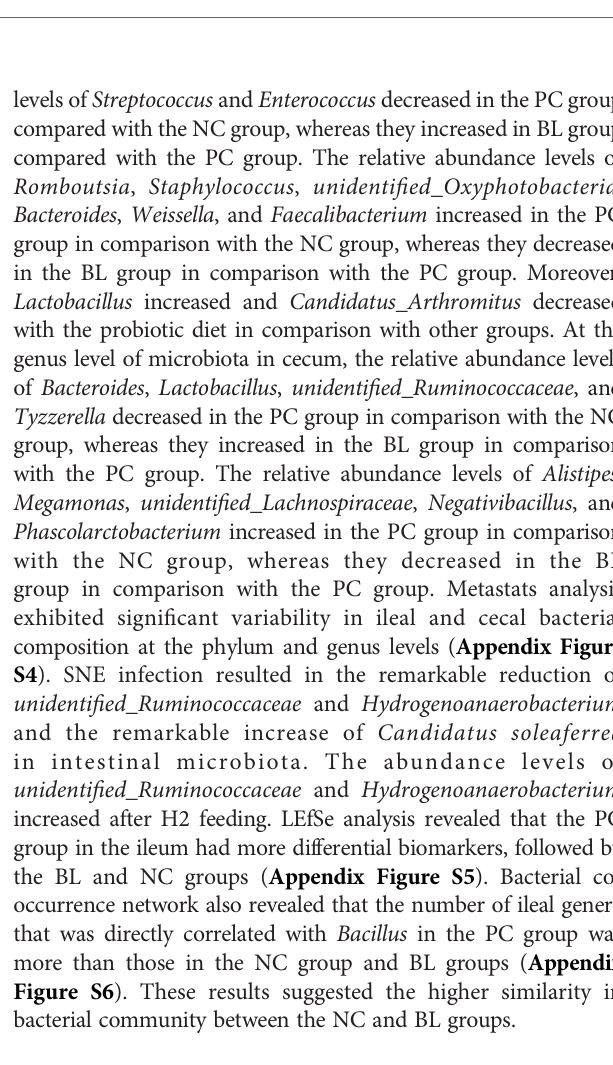
FIGURE 7 | Identi fi cation of differentially expressed genes in the liver. (A) RNA-Seq analysis reveals differentially expressed genes between the NC and the BL groups, the NC and the PC groups, and the PC and the BL groups. Red and blue colors represent up and downregulated transcripts, respectively. (B) Venn diagram for the